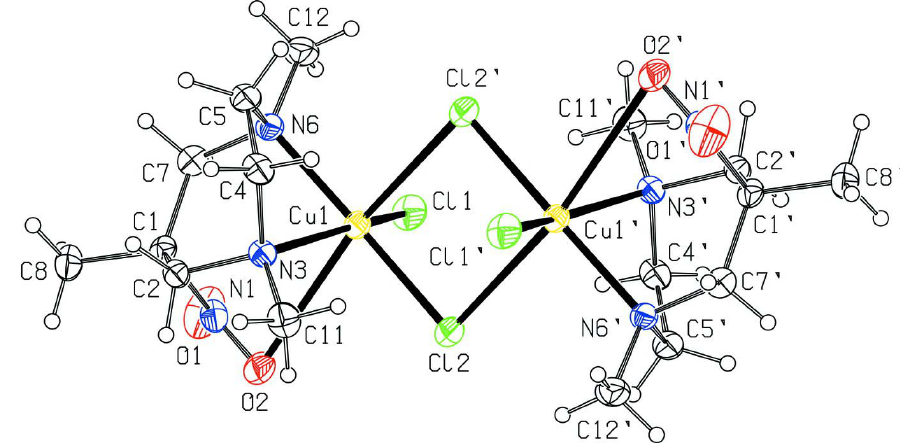
A view of the molecular structure of copper complex showing the atom-labelling scheme. Ellipsoids are drawn at the 30% probability level. H atoms are omitted for